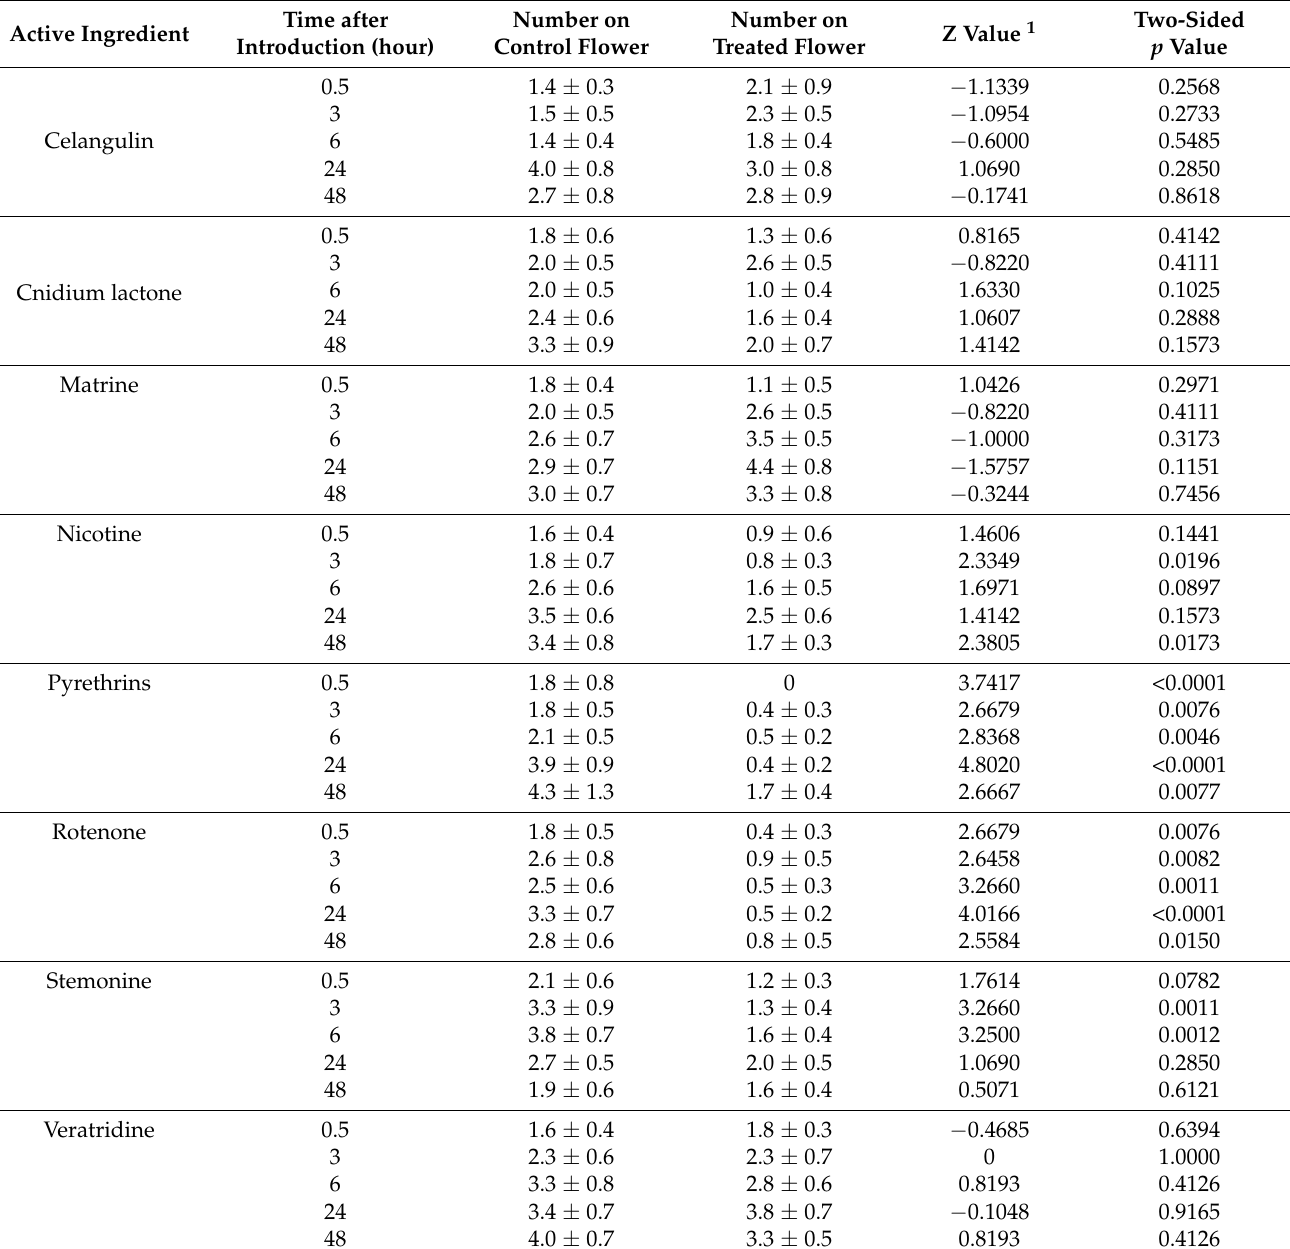
Table 1. Mean numbers ( ± SEM) adult western flower thrips observed on periwinkle flowers dipped